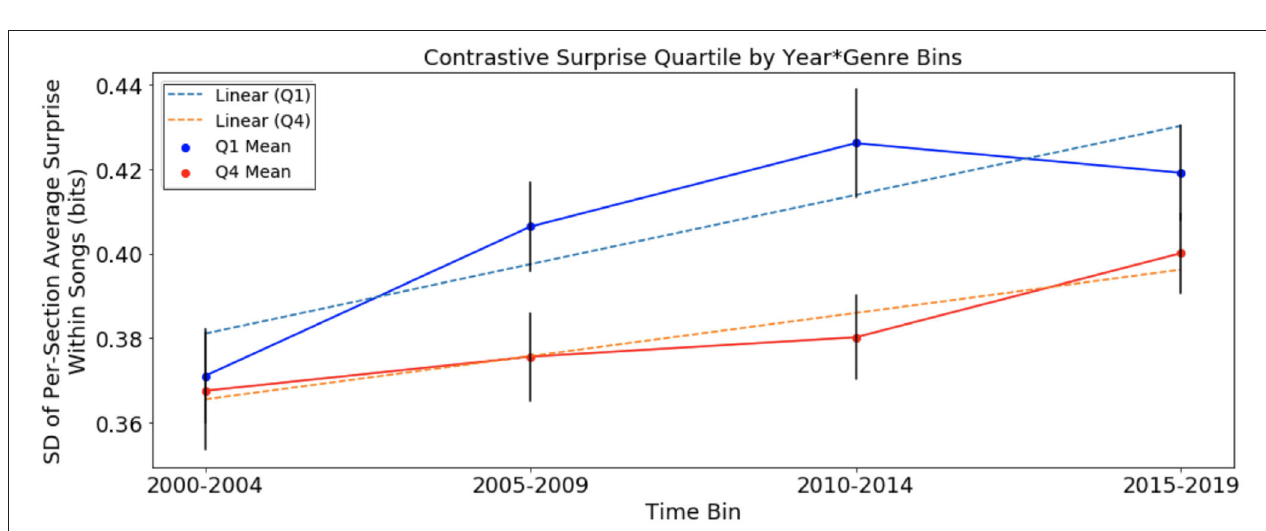
FIGURE 3 | Variation of harmonic surprise across sections of songs, with harmonic surprise calculated using chord distribution of August 1958 to January 1975, of Q 1 and Q 4 , separated into time bins. Error bars represent standard error. Variation of surprise across sections rises faster in Q 1 than in Q 4 .